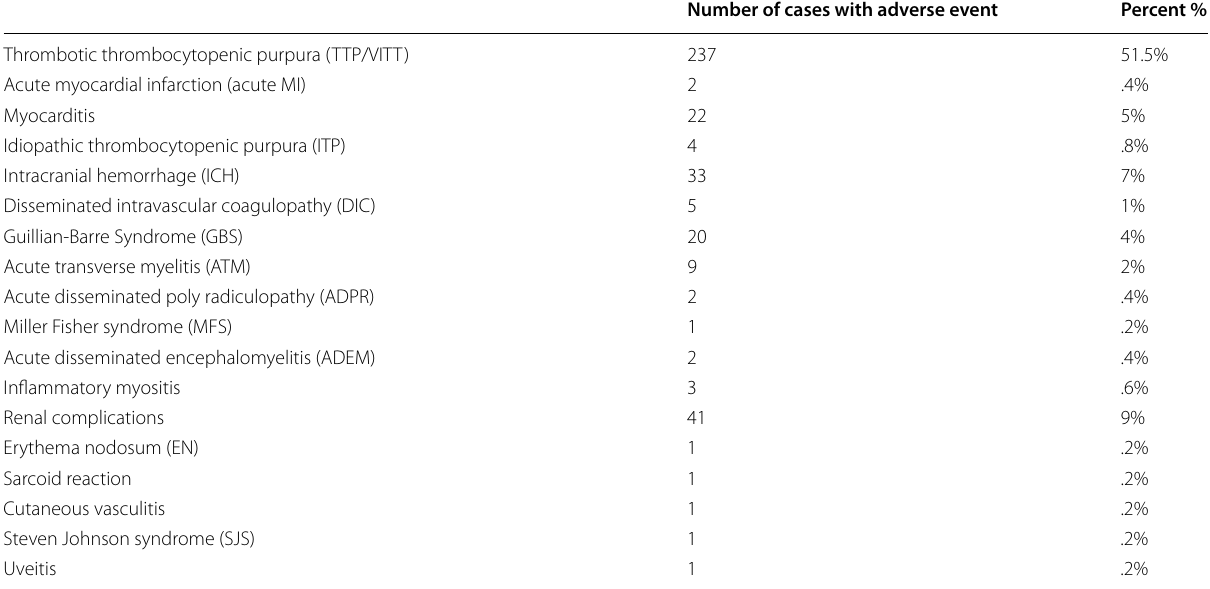
Table 1 Gathering involved studies data and patient characteristics as well as adverse